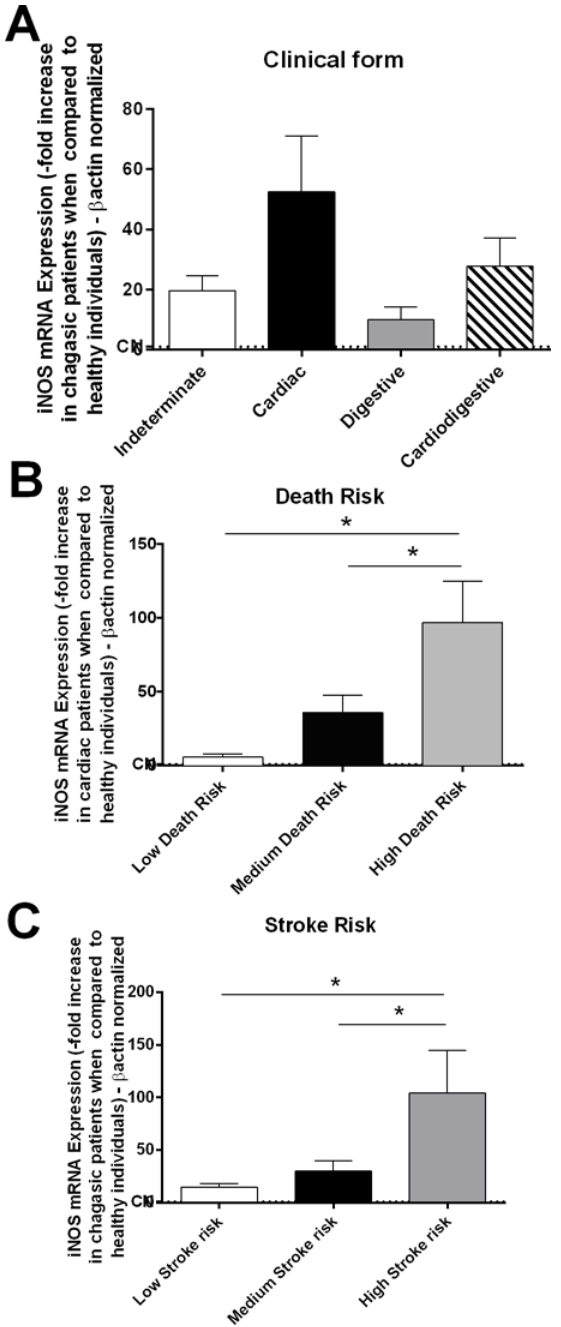
Fig 4. Patients who exhibited high death and stroke risks exhibited high iNOS expression. The mRNA expression levels of iNOS were determined by real-time PCR of peripheral blood mononuclear cells of chagasic patients with the indeterminate (n = 18), cardiac (n = 17), digestive (n = 15) and cardiodigestive (n = 15) forms of disease (A) . Patients were classified as having a high (n = 10), medium (n = 12), or low (n = 10) death risk (B) and were also grouped as having a low (n = 40), medium (n = 18) or high (n = 7) stroke risk (C). The expression of iNOS was normalized to the expression level of β -actin . The results are expressed as the means ± standard errors. * P <